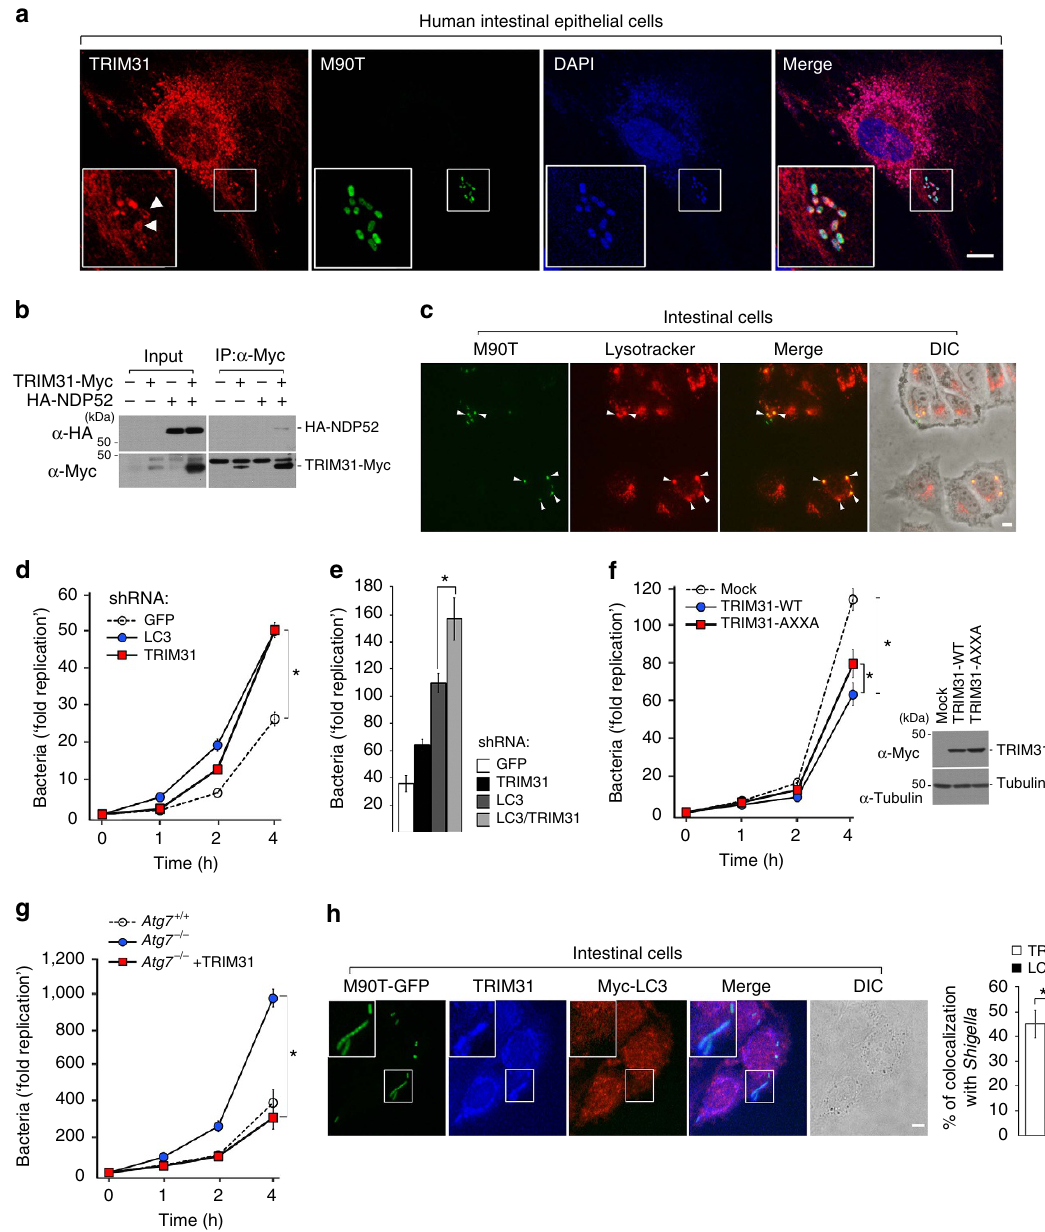
Figure 6 | TRIM31-induced autophagy restricts growth of invasive bacteria in the intestinal epithelial cells. ( a ) Extensive colocalization of endogenous TRIM31 with Shigella and accumulation of TRIM31 around the surface of Shigella . Intestinal epithelial cells were infected with GFP-tagged S. flexneri M90T strain (green) and chased in complete media for 1h with gentamicin (100 m gml (cid:2) 1 ) to eliminate extracellular bacteria. Cells were immunostained with anti- TRIM31 antibody (red), followed by counterstaining with DAPI (blue). Scale bar, 5 m m. ( b ) Cell lysates from HEK293T cells expressing TRIM31-Myc or HA-NDP52 were lysed with 0.5% NP-40, immunoprecipitated with anti-Myc antibody, and then subjected to immunoblot analysis with anti-HA antibody. ( c ) Caco-2 cells were infected with GFP-tagged M90T and incubated with Lysotracker. Arrowheads indicate colocalization of intracellular Shigella with Lysotracker. DIC, differential interference contrast. Scale bar, 5 m m. ( d ) The bacteria recovery assay was performed in HT-29 cells stably expressing shRNA GFP (open circles), shRNATRIM31 (closed red squares), or shRNA LC3 (closed blue circles). Cells were infected with M90Tstrain and chased in complete media with gentamicin (100 m gml (cid:2) 1 ) for the indicated times. * P o 0.01 (Student’s t -test). ( e ) The bacterial recovery assay in HT-29 cells stably expressing shRNA against GFP, TRIM31, LC3 or LC3 and TRIM31. * P o 0.01 (Student’s t -test). ( f ) HeLa cells stably expressing control pLHCX vector (Mock, open circles), wild-type TRIM31-Myc (WT, closed blue circles), or AXXA-mutated TRIM31-Myc (AXXA, closed red squares) were infected with M90T-GFP. Expression of WT-TRIM31-Myc or AXXA-TRIM31-Myc was confirmed by immunoblot analysis using anti-Myc antibody. * P o 0.01 (Student’s t -test). ( g ) Wild-type or Atg7 (cid:2) / (cid:2) cells stably expressing mock or TRIM31-Myc were infected with M90T-GFP. * P o 0.01 (Student’s t -test). Open circles, Atg7 þ / þ ; closed blue circles, Atg7 (cid:2) / (cid:2) ; closed red squares, Atg7 (cid:2) / (cid:2) þ TRIM31. ( h ) Caco-2 cells stably expressing Myc-LC3 were infected with M90T-GFP (green) and incubated with media containing gentamicin (100 m gml (cid:2) 1 ) for 1h. Cells were immunostained with anti-TRIM31 (blue) and anti-Myc (red) antibodies. DIC, differential interference contrast. Scale bar, 5 m m. Right graph, quantification of TRIM31- or LC3-positive bacteria in Caco-2 cells. * P o 0.01 (Student’s t -test). All data are representative of at least three independent experiments (mean ± s.d. in d – h